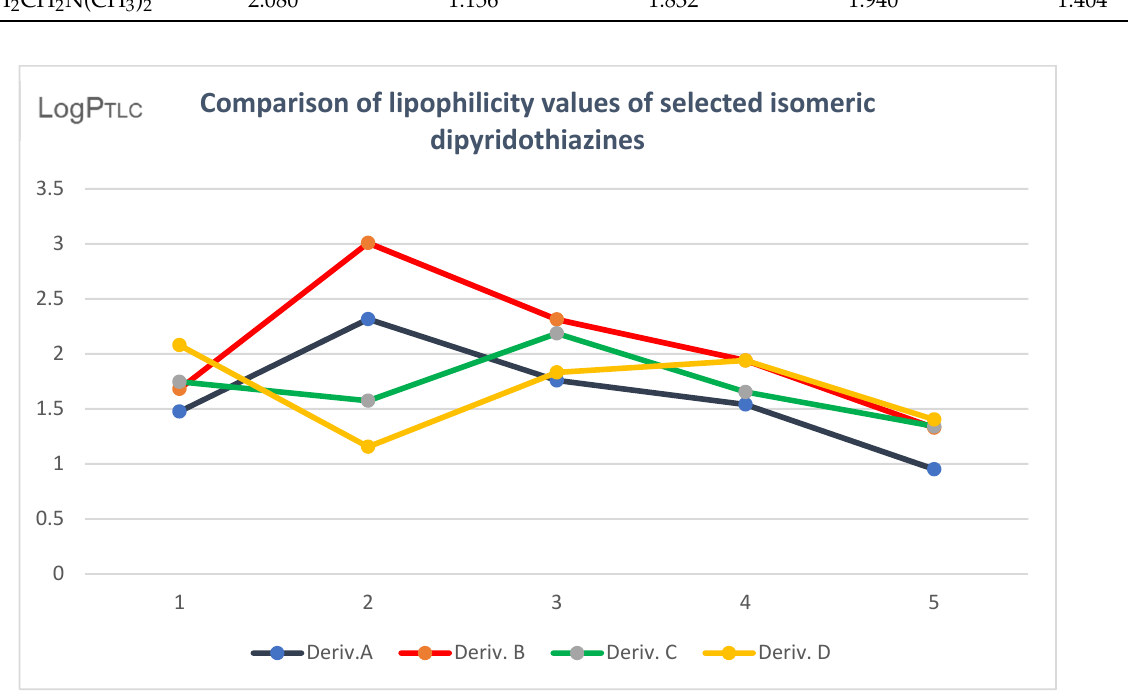
Figure 5. Graphical visualization of log P TLC values of the selected derivatives ( A – D ) of 1,9- 1,6-, 1,8-, 2,7- and 3,6-diazaphenothiazines [30–33].